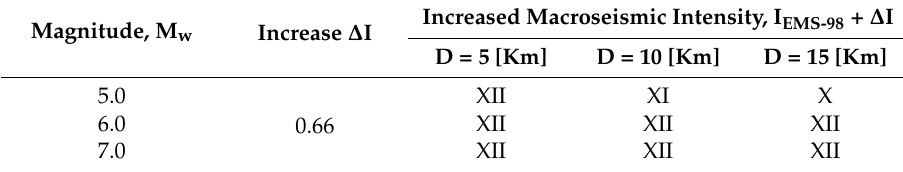
Table 4. Macroseismic intensity increase, ∆ I , for different